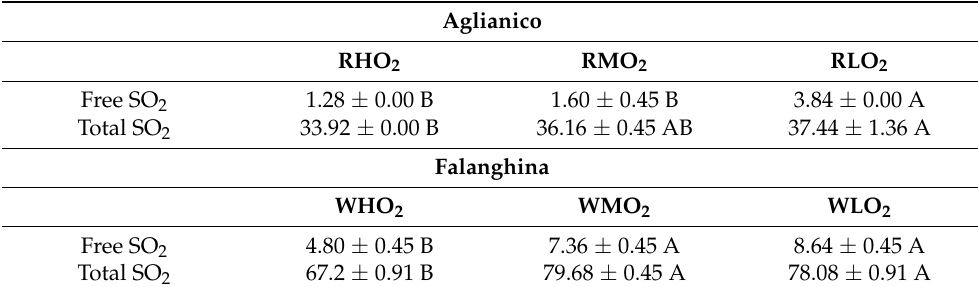
Table 1. Evolution of free sulfur dioxide and total sulfur dioxide after 11 months of aging of treated red Aglianico and white Falanghina